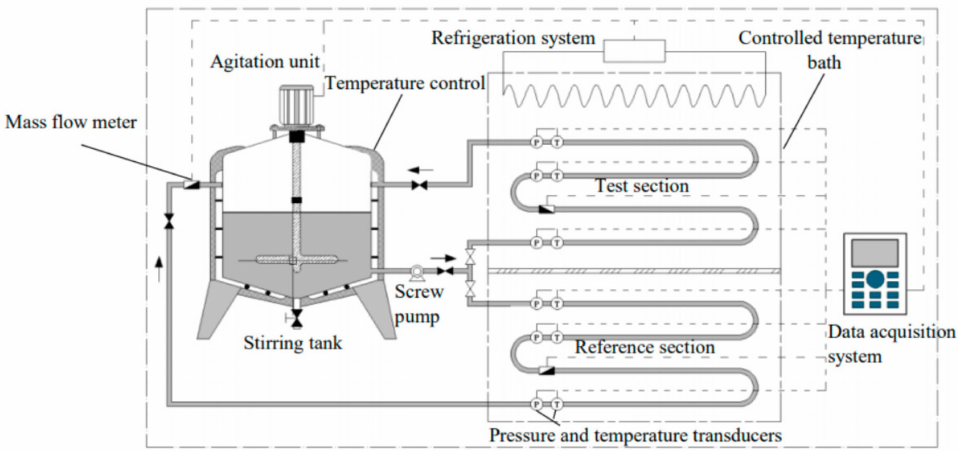
Figure 7. Schematic diagram of the flow loop apparatus